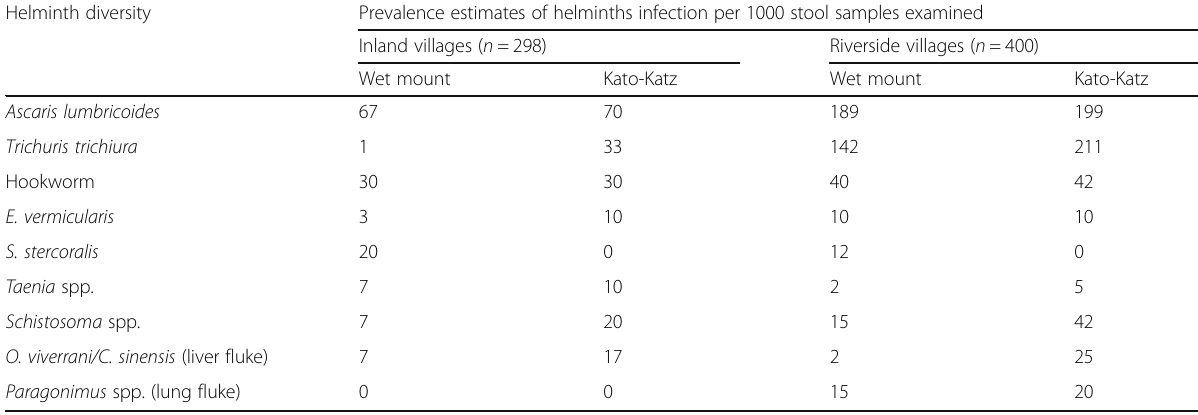
Table 2 Prevalence estimates of helminths infection per 1000 stool samples examined in Shwegyin township, Myanmar, stratified by location of villages and the type of laboratory method used, 2017 Helminth diversity Prevalence estimates of helminths infection per 1000 stool samples examined Inland villages ( n = 298) Wet mount Kato-Katz Wet